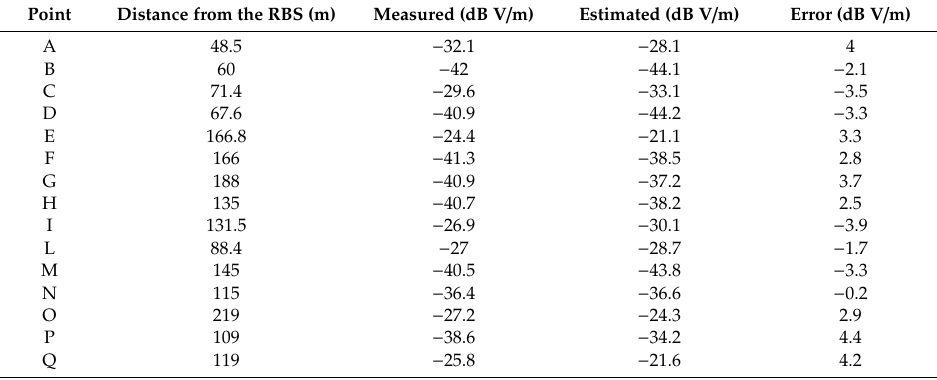
Table 2. Results of the Dorgali measurement campaign (944.2 MHz, Kathrein 730376). Point Distance from the RBS (m) Measured (dB V / m)